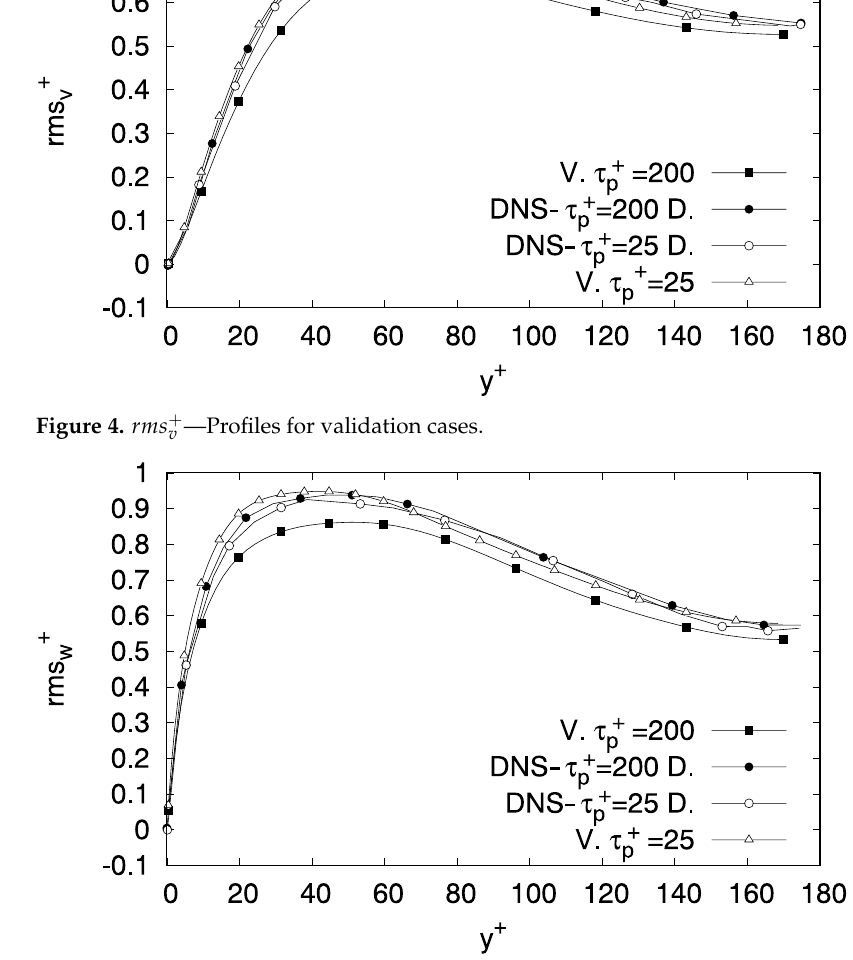
Figure 5. rms + w —Profiles for validation